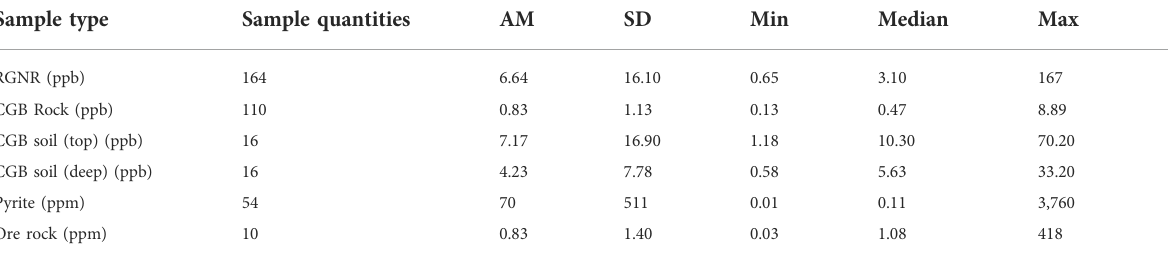
TABLE 1 Statistical parameters of gold content of multimedium in Jiaodong.